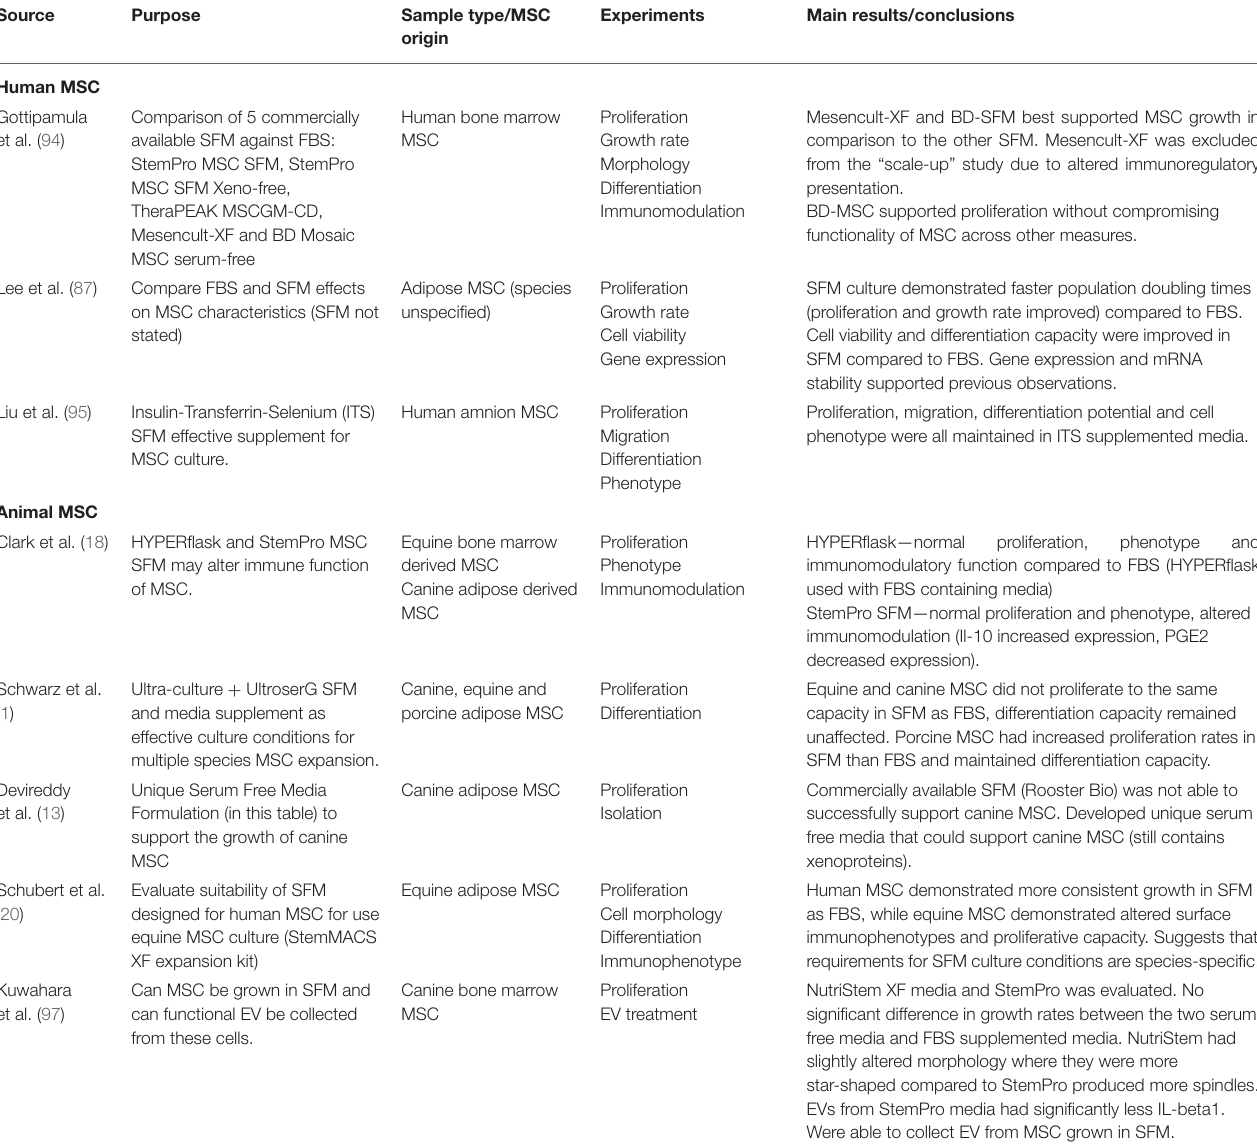
TABLE 4 | Serum free media evidence